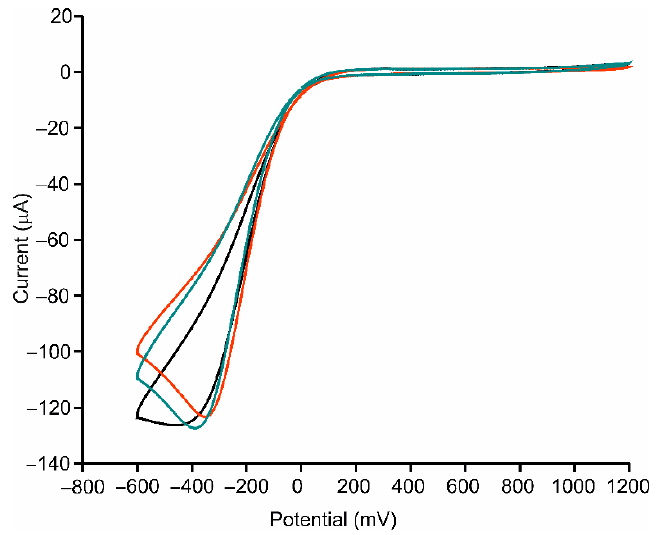
Figure 10. Voltammetric response in catechol 10 − 4 mol·L − 1 in 0.01 mol·L − 1 PBS, pH 7.0 of three dif-